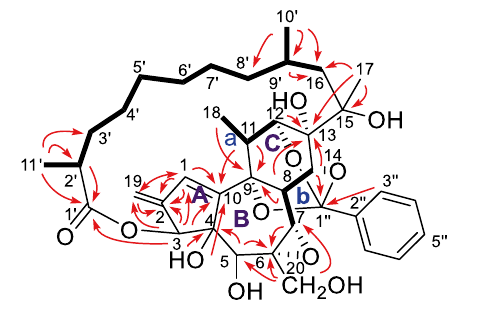
Fig. 2 Partial fragments ( a - c ), 1 H, 1 H COSY (